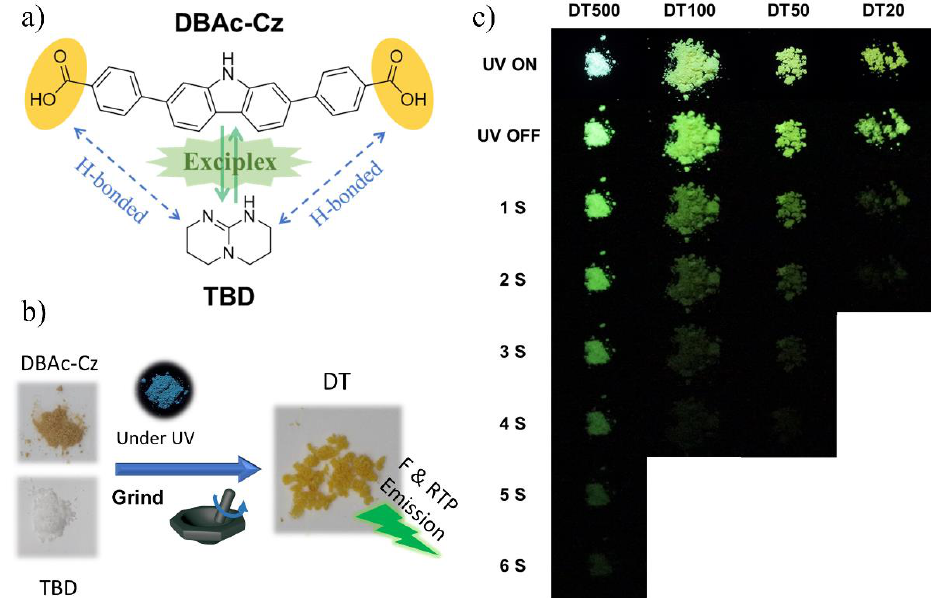
Figure 1. ( a ) Chemical structure of DBAc-Cz and TBD and the formation of exciplex between the two molecules by H-bonds. ( b ) Photographs of DBAc-Cz, TBD, DT and excited DBAc-Cz with UV irradiation (F-fluorescence). ( c ) Photographs of excited DTs after removal of UV irradiation. Note: all the UV irradiation is at 365 nm.